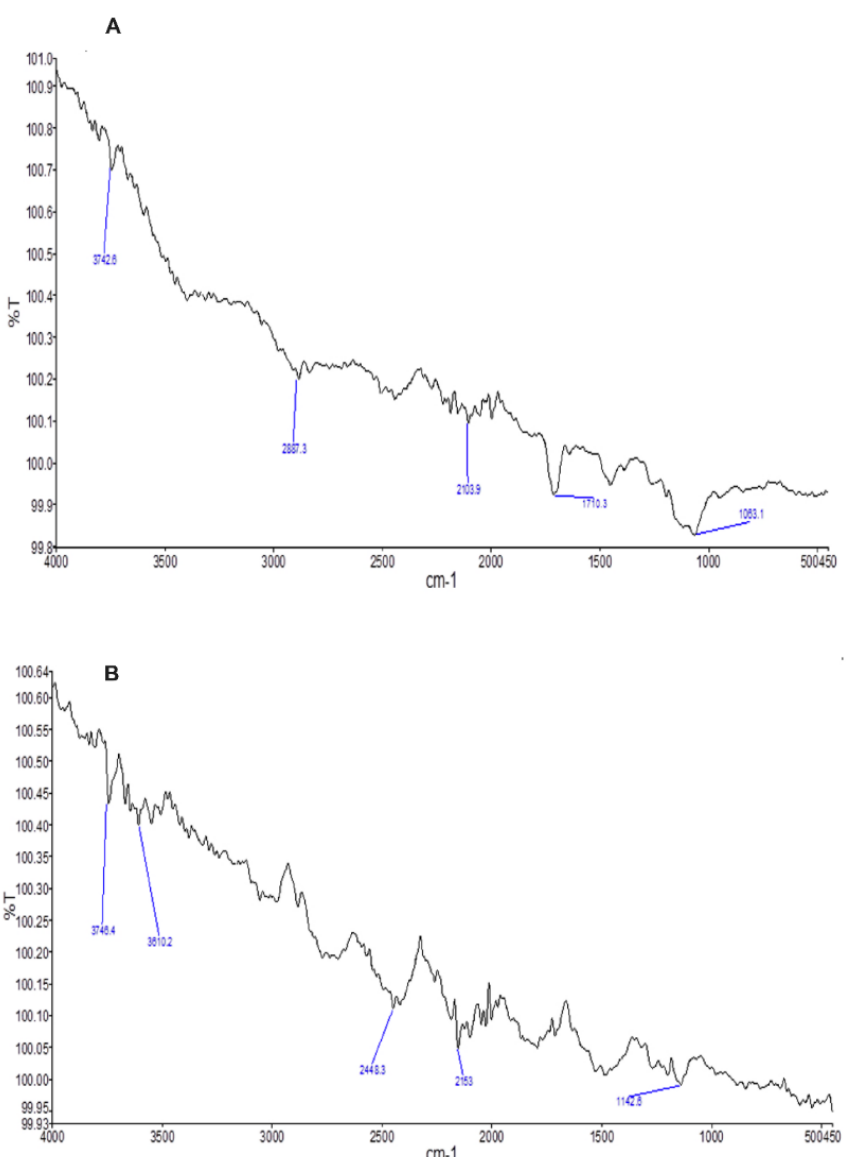
Figure 1. Graphical representation of ( A ) clarithromycin and ( B ) formulation F1 formulation FTIR spectra.